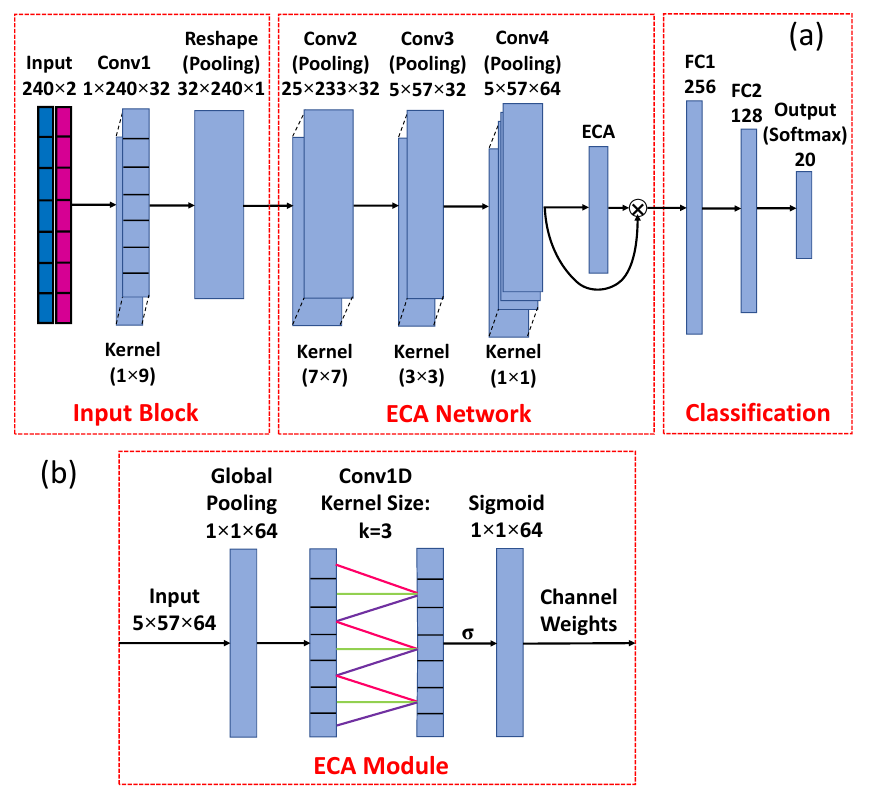
Figure 5. ( a ) A schematic of the ECA network comprised by input block, ECA network, and fully connected layers for classification; ( b ) the structure of the ECA module. The two layers in the middle depict a 1D convolution of the channel-wise data with a kernel size of